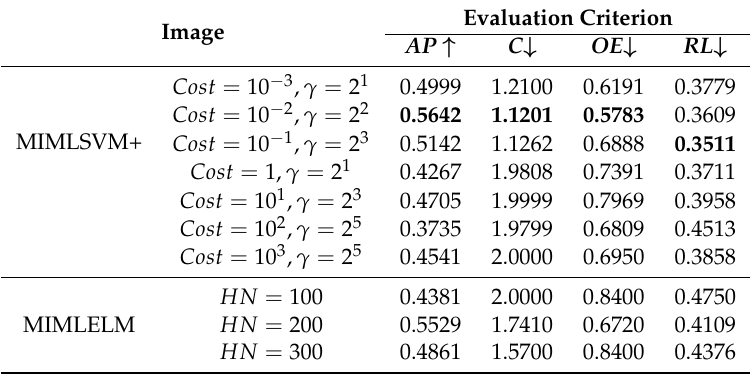
Table 2. The effectiveness comparison on the Image data set. AP : average precision; C : coverage;